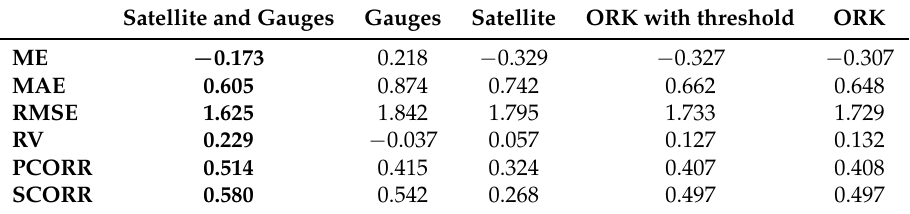
Table 8. Regression scores averaged on the automatic test stations. The ME, the MAE and the RMSE are expressed in